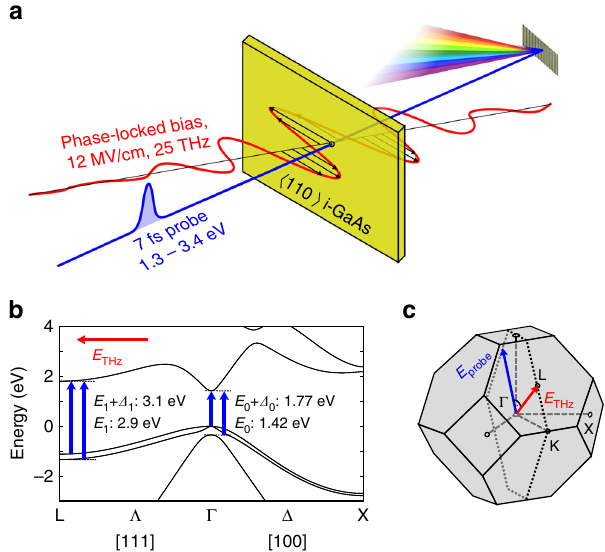
Fig. 1 Experimental scheme and fundamental materials properties of GaAs. a A few-cycle mid-infrared waveform centered at 25 THz (sketched in red) propagates into a <110>-oriented thin fi lm of intrinsic GaAs (yellow). The electric fi eld amplitude reaches up to 12 MV/cm inside the material, with polarization set to the [111] crystallographic direction. The resulting changes in interband electronic absorption are probed at variable times relative to the biasing fi eld, with weak 7-fs optical pulses containing photon energies from 1.3 eV to 3.4 eV (blue). After transmission through the sample, the broadband probe pulses are spectrally dispersed with a monochromator and detected with a CCD array. b Electronic band structure of GaAs at room temperature, with interband critical points and transition energies relevant to the experiment depicted by blue arrows. The direction of the mid-infrared biasing fi eld E THz is indicated in red. c First Brillouin zone of the zincblende-type crystal structure of GaAs, with direction of biasing fi eld E THz and probe polarization E probe given by red and blue arrows, respectively. The dotted line indicates the intersection with the <110>- oriented surface of